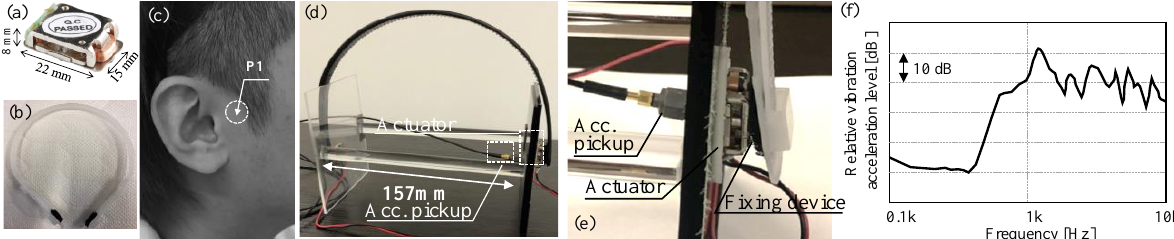
Figure 2. ( a ) Actuator used for the bone-conducted sound reproduction, ( b ) hairband-type fixing device of the actuator, ( c ) contact position of the actuator, ( d , e ) measurement settings of the excitation characteristics of the adopted actuator with the fixing device, and ( f ) measured frequency characteristics of the vibration acceleration exited by the actuator.